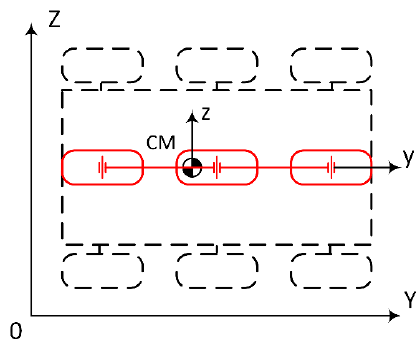
Figure 3. Concept of half vehicle model.